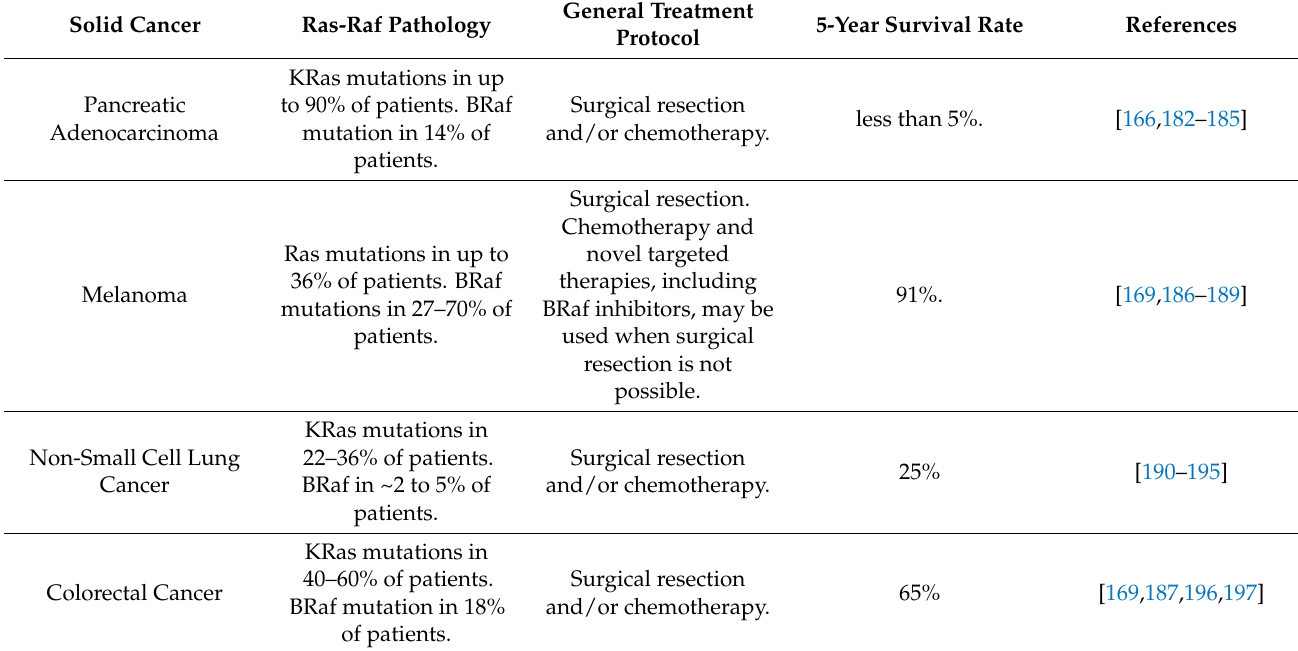
Table 2. Various solid cancers associated with Ras-Raf